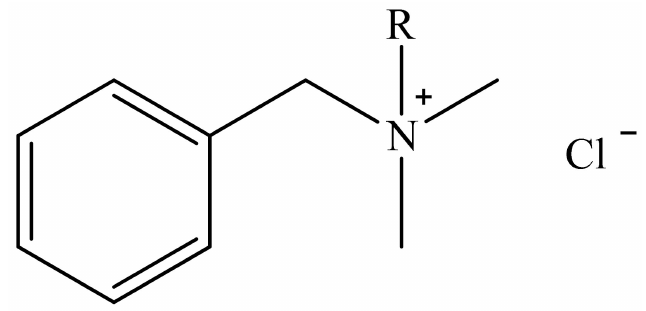
Figure 5. Chemical structure of benzalkonium chloride ( N -alkyldimethylbenzylammonium chloride)